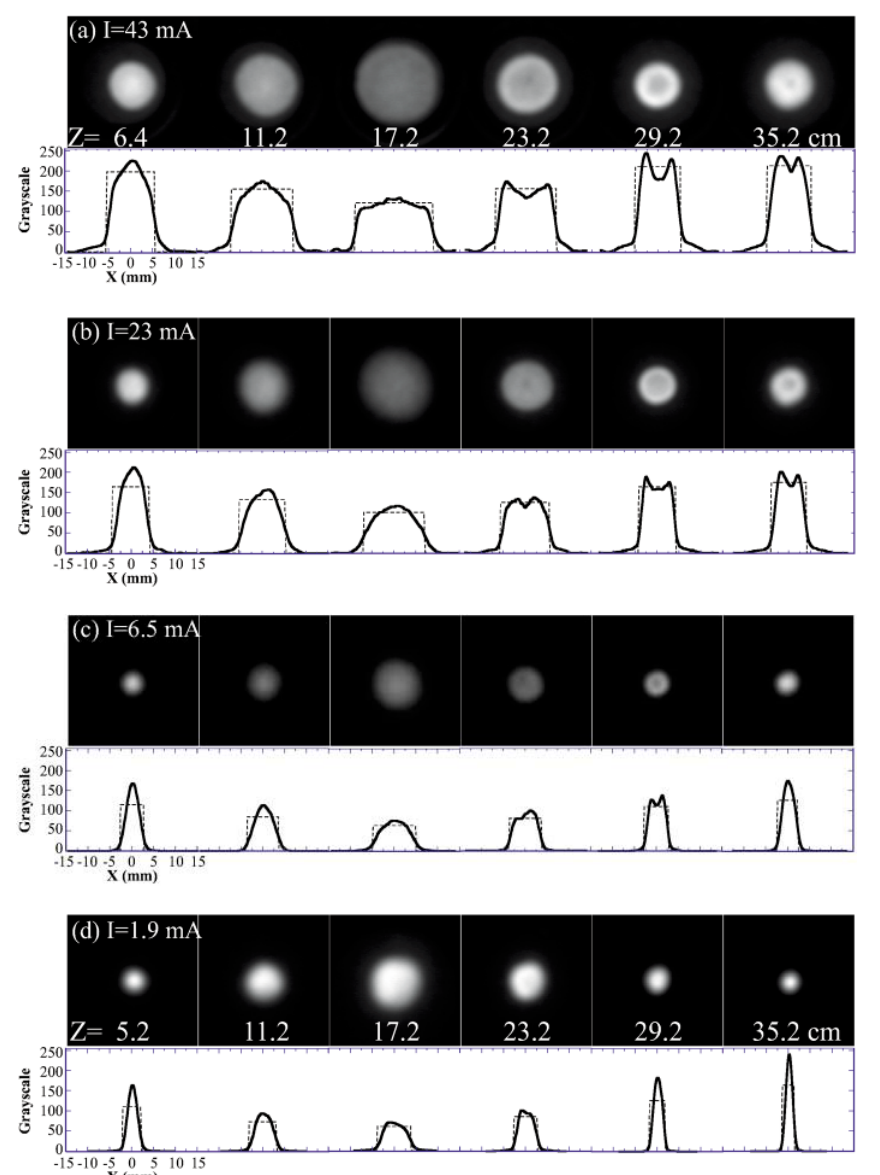
FIG. 2. (Color) Solenoid focusing of a 5 keV electron beam for different currents (see Table I). The fluorescent screen pictures and normalized horizontal intensity profiles are shown for (a) full beam (43 mA), (b) 2.85 mm (radius) aperture, (c) 1.5 mm (radius) aperture, and (c) 0.875 mm (radius) aperture. The distance z is measured from the aperture plate (see Fig. 1). The solenoid is located at z (cid:1) 16.1 cm and has a peak on-axis field B z (cid:1) 84.2 G. The vertical scales on the beam profiles are in units of a gray scale where 0 is black and 256 is white. The dotted rectangular plots represent the equivalent KV